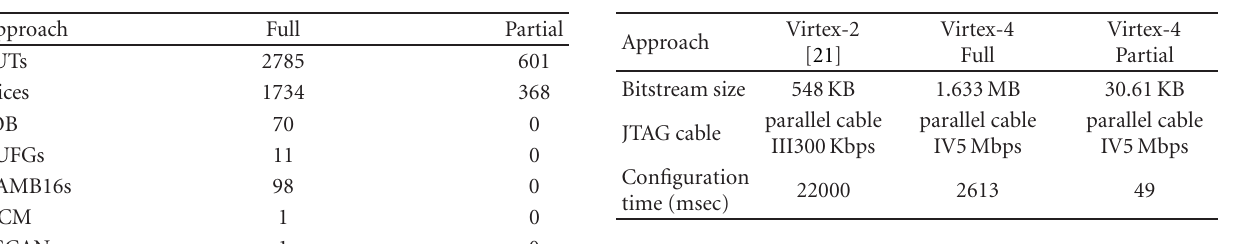
Table 7: Static versus partial resource usage comparison. Table 8: Virtex-2 versus Virtex-4 configuration comparison.